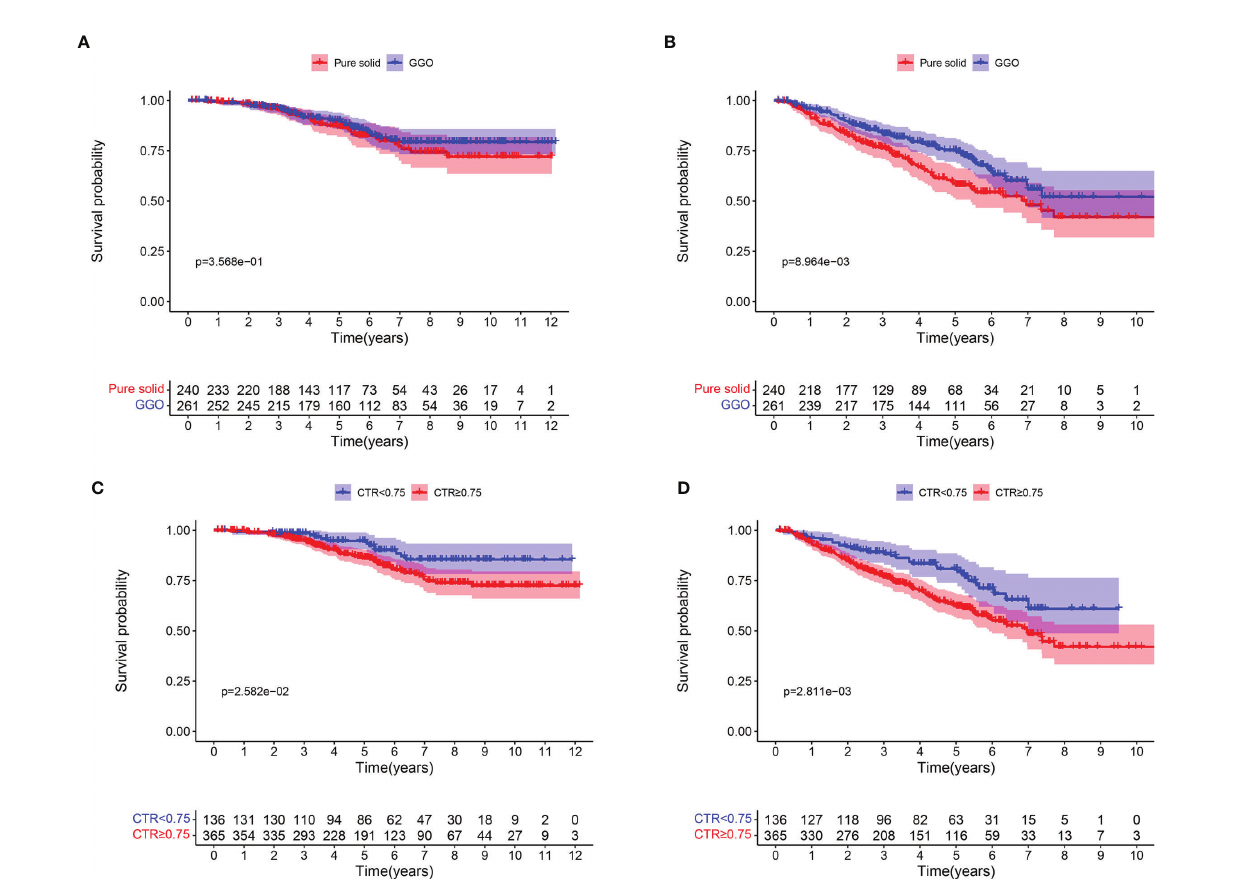
FIGURE 1 | Survival curves for patients with pure solid nodule and GGO nodules. (A) Overall survival; (B) Disease-free survival. Survival curves for patients with CTR <0.75 AND CTR ≥ 0.75. (C) Overall survival; (D) Disease-free